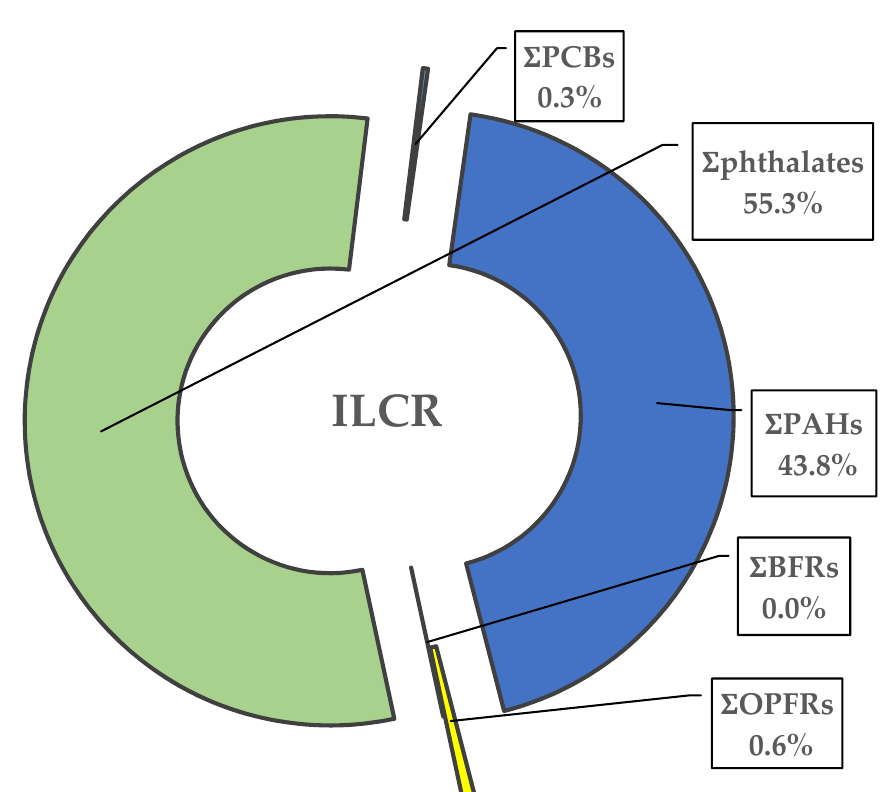
Figure 5. Chemical profile (%) of the estimated ILRC from car dust.